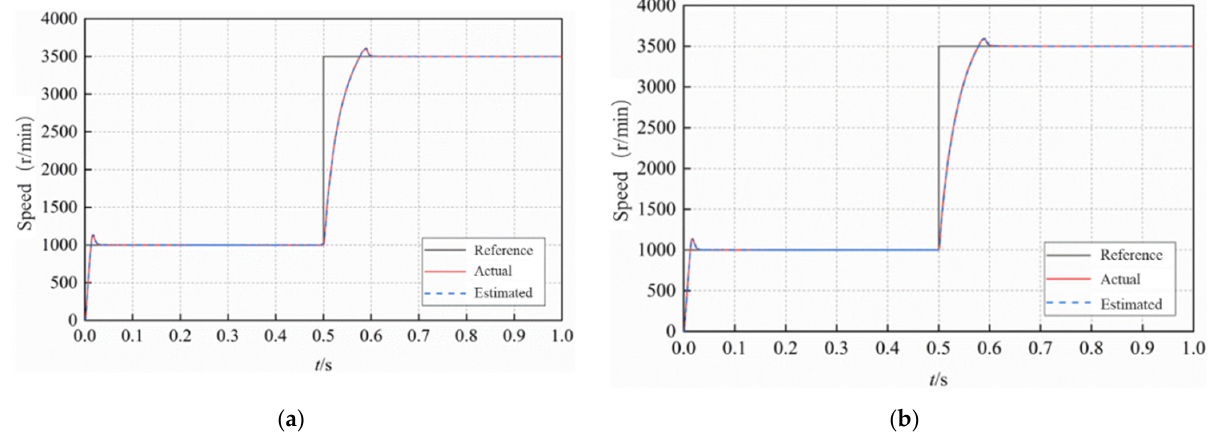
Figure 10. Simulation waveform of motor speed when speed mutation occurs. ( a ) Traditional MRAS algorithm. ( b ) STSM − MRAS algorithm.